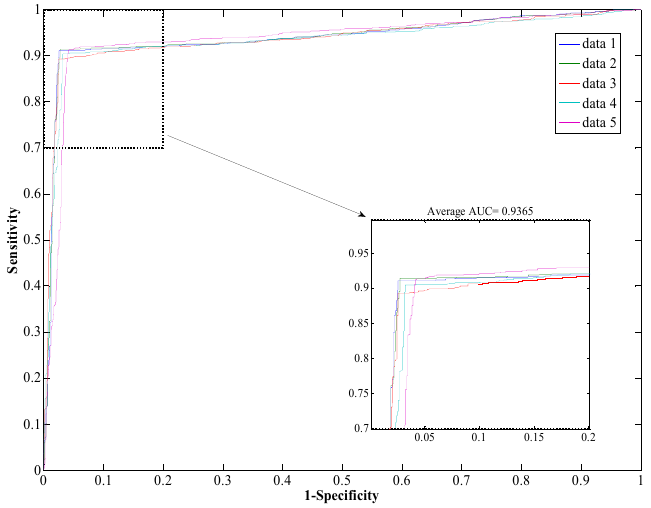
Figure 3. ROC from proposed method result for S. cerevisiae PPI dataset.